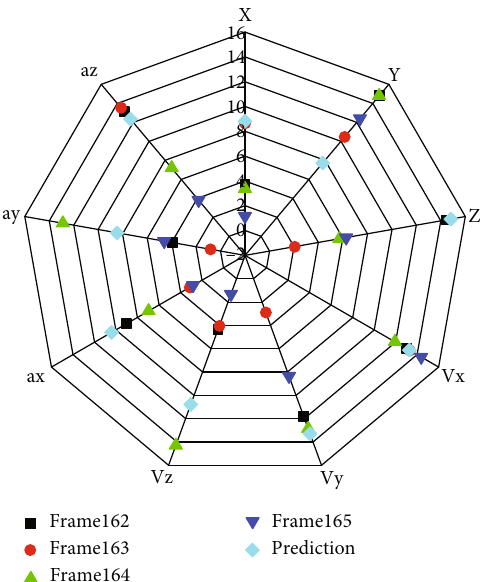
Figure 7: Motion parameters and trajectory prediction of feature points.